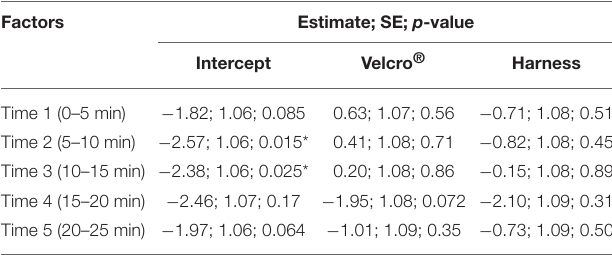
TABLE 3 | Results of the repeated measures ANOVA examining stroke frequency (Hz) with the interaction of treatment and time (5 min blocks).